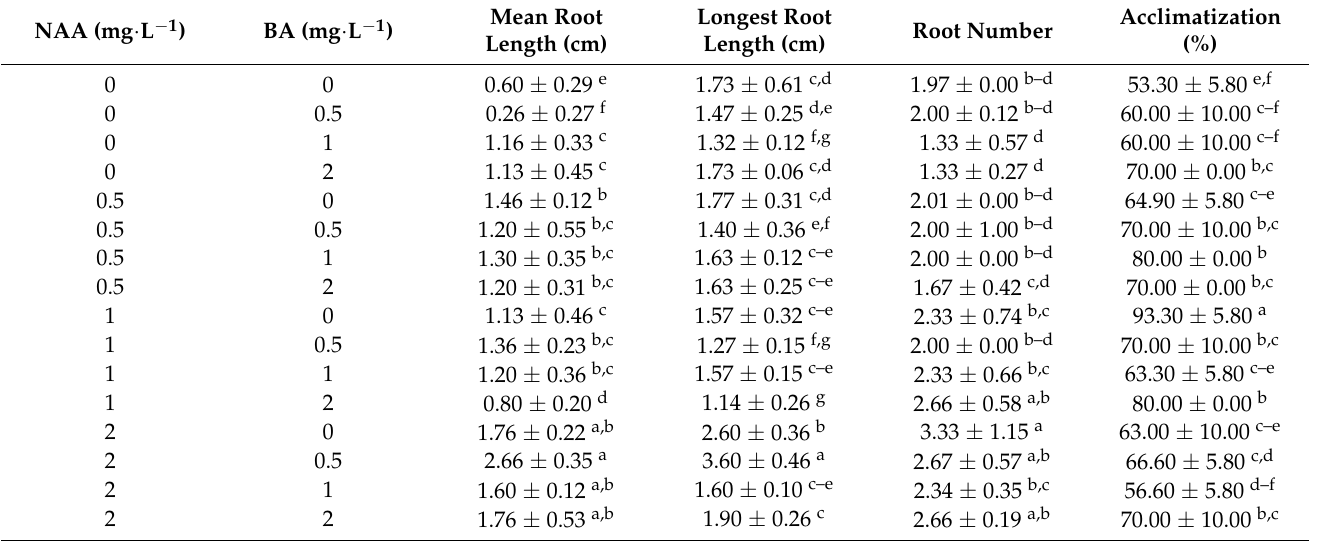
Table 3. Effect of different concentrations of NAA and BA on the measured characteristics of Zamioculcas zamiifolia (Lodd.) Engl. ‘Dowon’ grown in vitro in the rooting and acclimatization